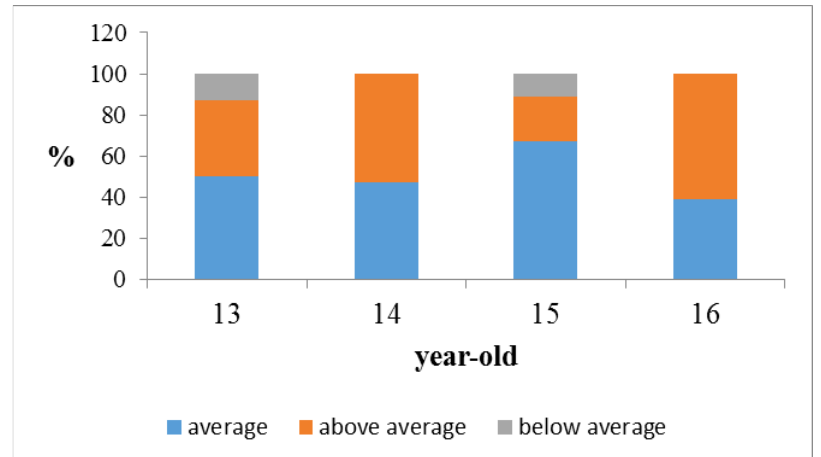
Fig. 3. Intra-group distribution of hockey players from 13 to 16 years old according to the BMI relative to